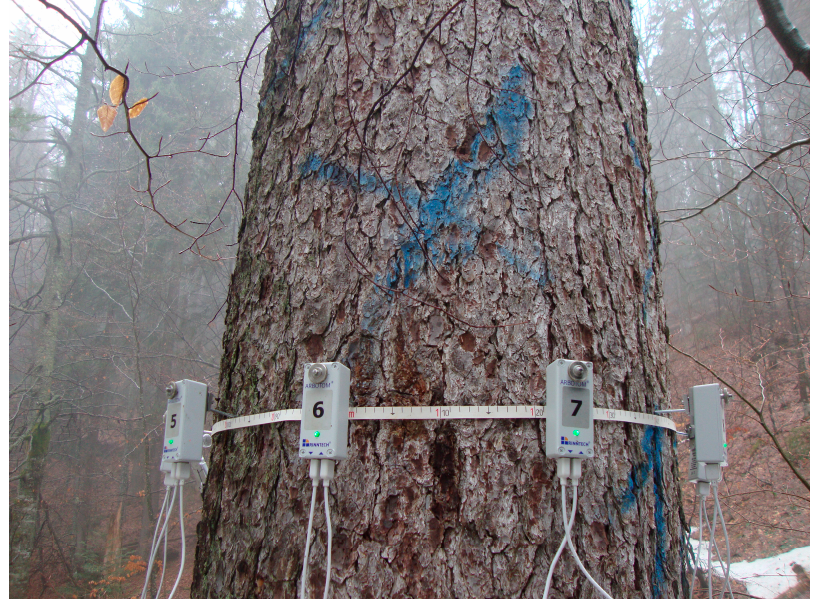
Figure 3. Caption of a tomography in the field.